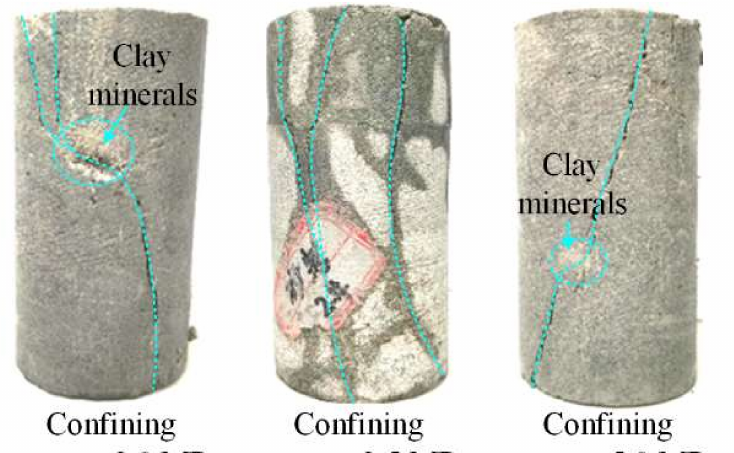
Figure 5. WCS sample